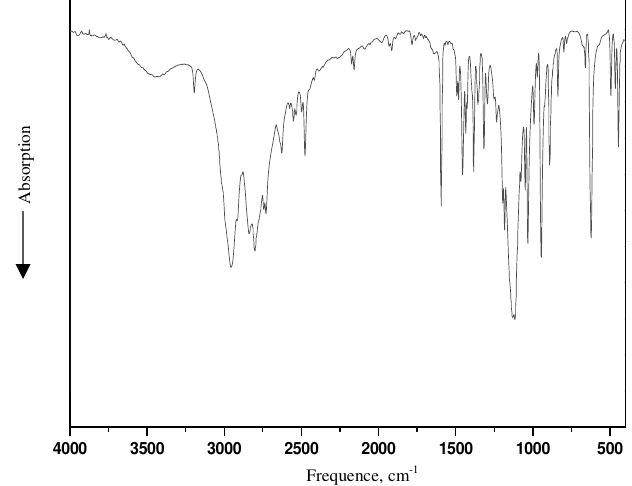
Figure 5. Infrared absorption spectrum of (C